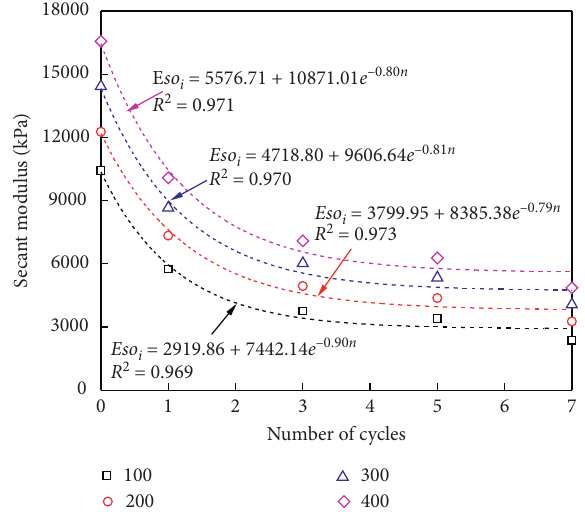
Figure 3: Relationships between secant modulus and the number of wetting-drying-freezing-thawing cycles.